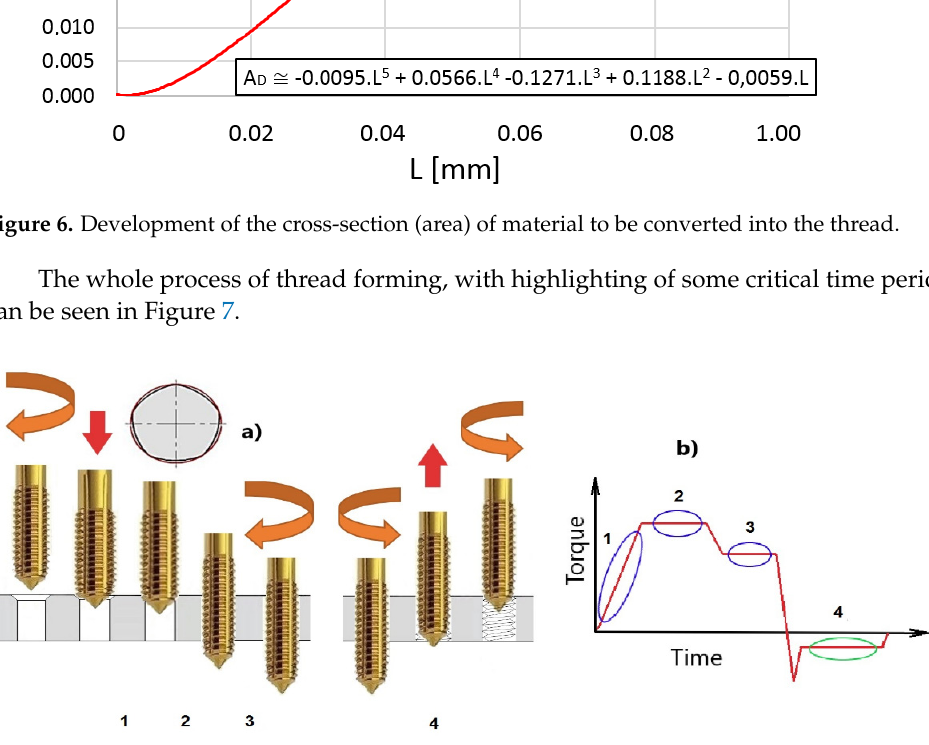
Figure 7. Evolution of the thread production; ( a ) significant positions, ( b ) significant phases for assessment.